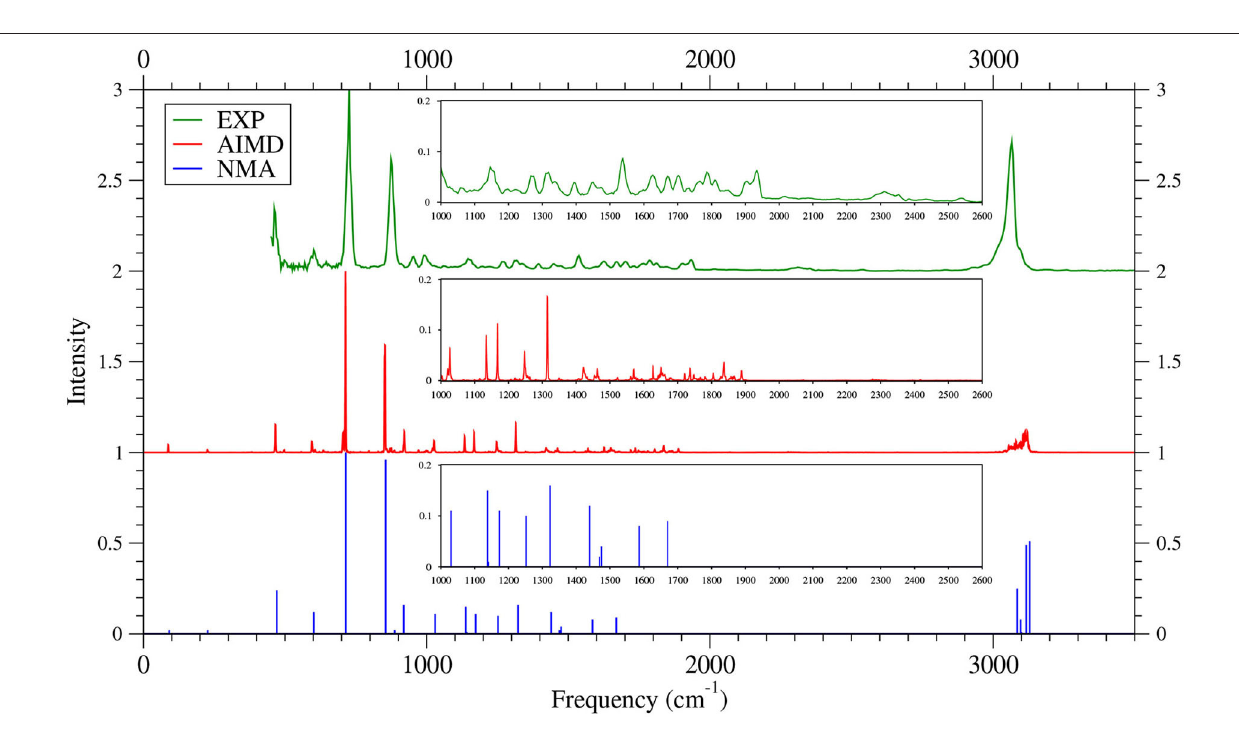
Frontiers in Chemistry | www.frontiersin.org